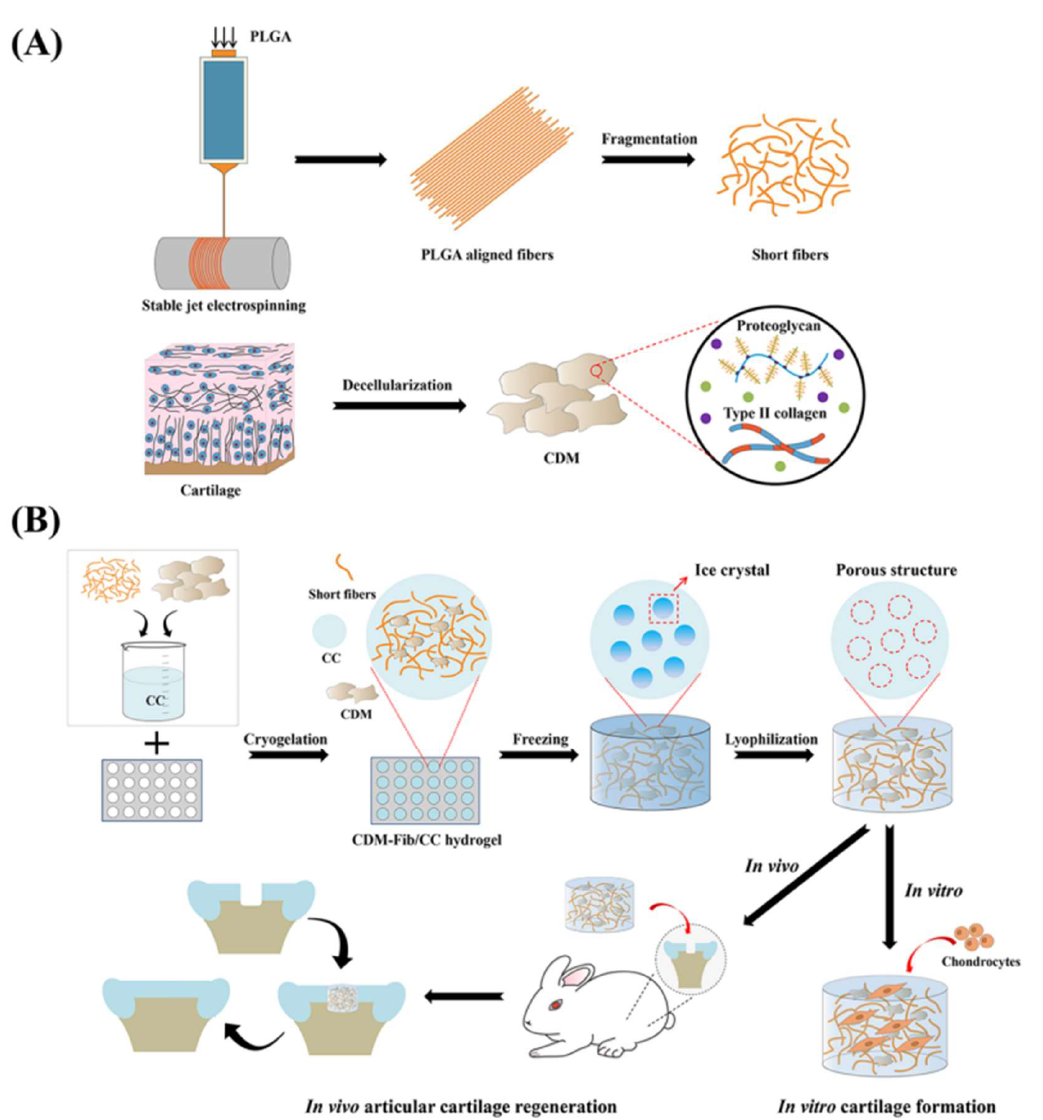
Figure 1. Shen et al. constructed a highly biomimetic PLGA-chitosan scaffold for cartilage regeneration. ( A ) Preparation of PLGA short fibers and CDM and ( B ) preparation of the PLGA-chitosan scaffold (CDM-Fib/CC). Reprinted with permission from Ref. [56]. 2021, American Chemical Society